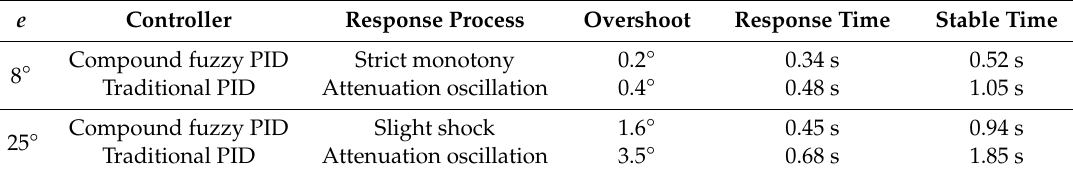
Table 5. Performance comparison of control algorithms.